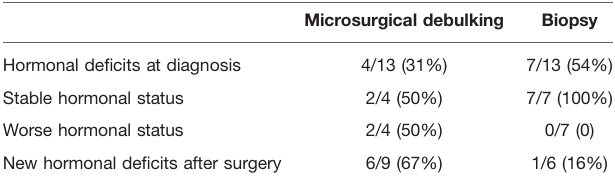
TABLE 5 | Endocrinological defects before and after